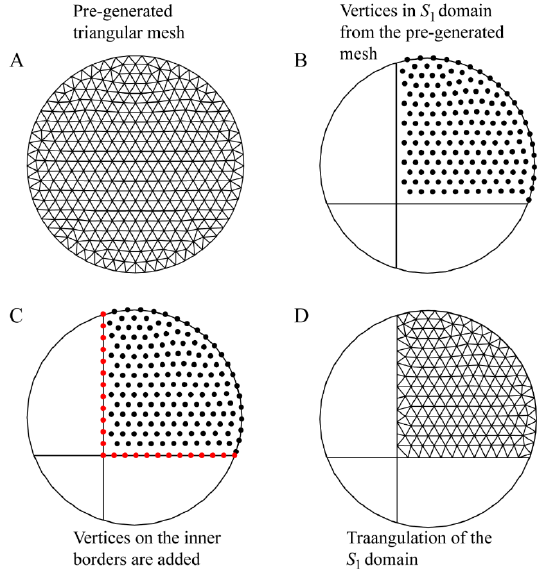
Figure 3. The triangulation for the domain of 𝑆 1 . Panel ( A ) shows the pre-generated triangulation of a disk with a desired resolution. In panel ( B ), vertices in the domain for 𝑆 1 are identified and collected. In this process, those vertices that are too close to the inner border lines are excluded. Panel ( C ) shows newly added vertices on the inner border lines (red dots) with a similar spatial resolution. The triangulation based on the black and red vertices is done in panel ( D ). The value of 𝑆 1 is calculated using this triangulation.